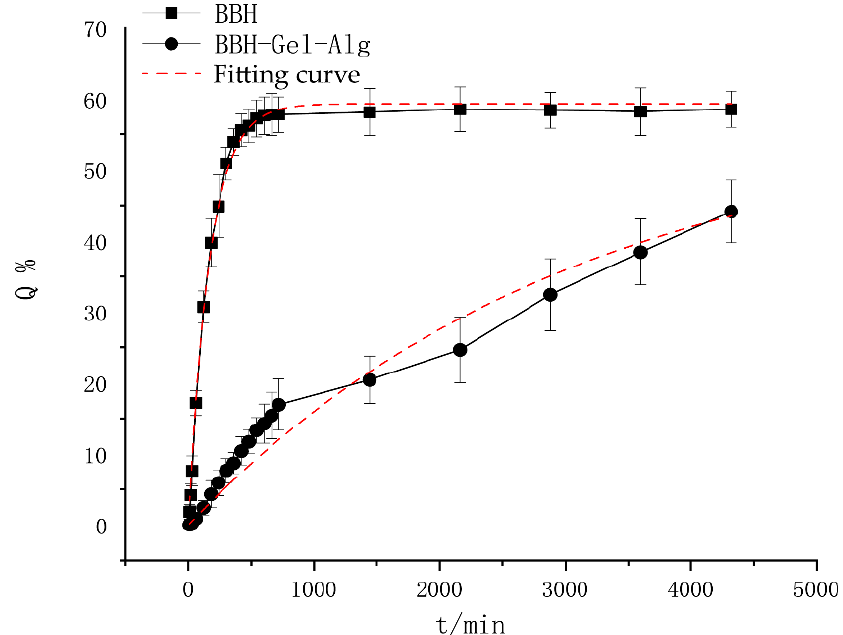
Figure 6. The release of BBH and BBH–Gel–Alg at different times in vitro. Table 3. Release kinetic formulas of BBH and BBH–Gel–Alg.